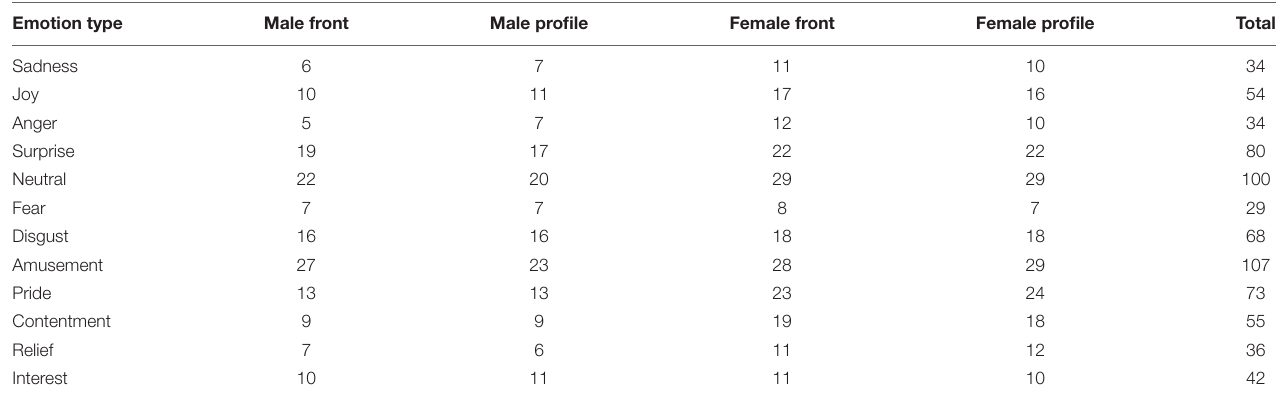
TABLE 1 | Number of pictures of the entire set, classified by gender and face orientation. Emotion